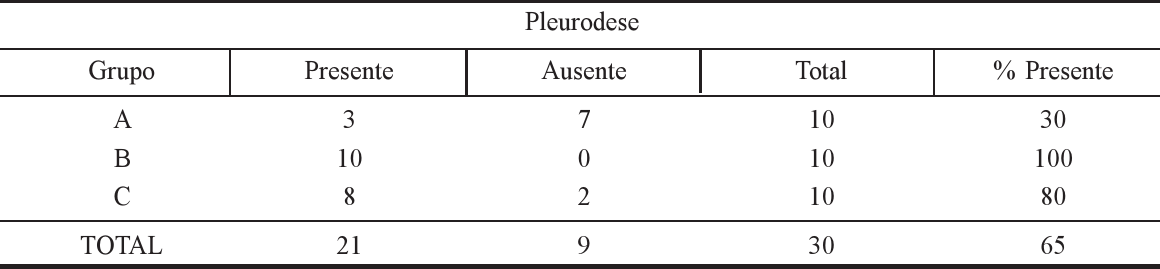
TABELA 3 - Coelhos submetidos a inje(cid:231)ıes intrapleurais, a cada 3 ou 4 dias, tetraciclina 7 mg/kg no grupo A (simula(cid:231)ªo), no grupo B (deriva(cid:231)ªo pleuroperitoneal) e no grupo C (drenagem), segundo os valores de pleurodese (presente, ausente).